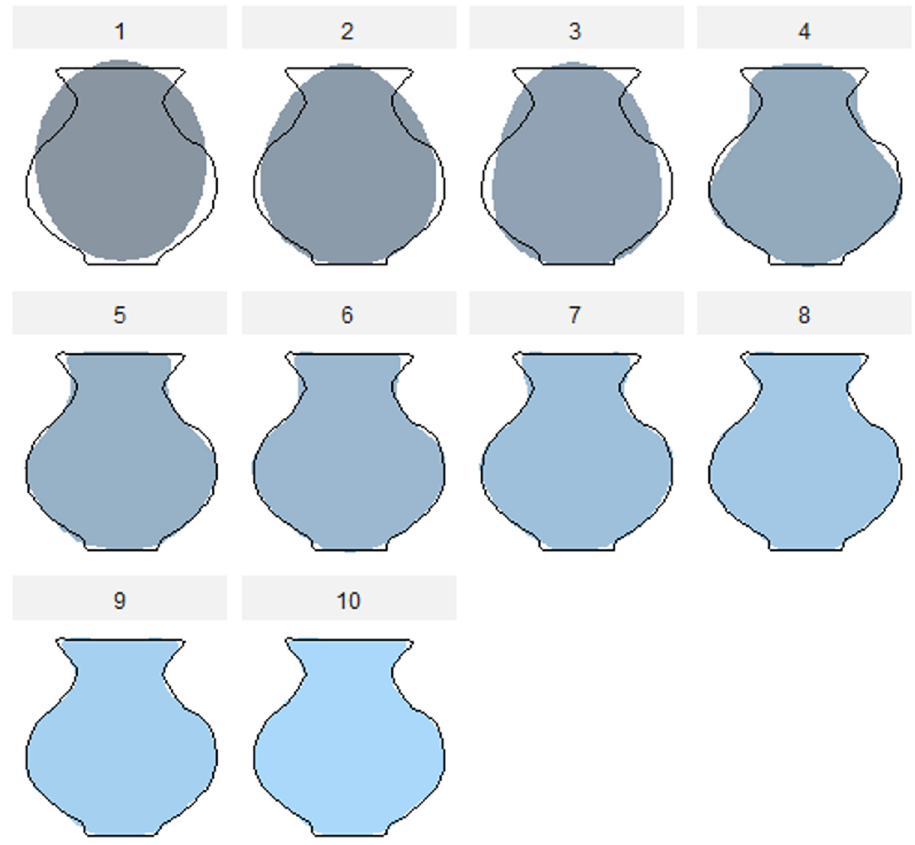
Figure 8: Visual representation of di ff erential numbers of harmonics ( 1 – 10 ) on captured vessel shape “ calibrate_reconstruc - tions_e - fourier ” function. Lower harmonics results in less accuracy in capturing vessel morphology, 10 harmonics captures 99% of variance.